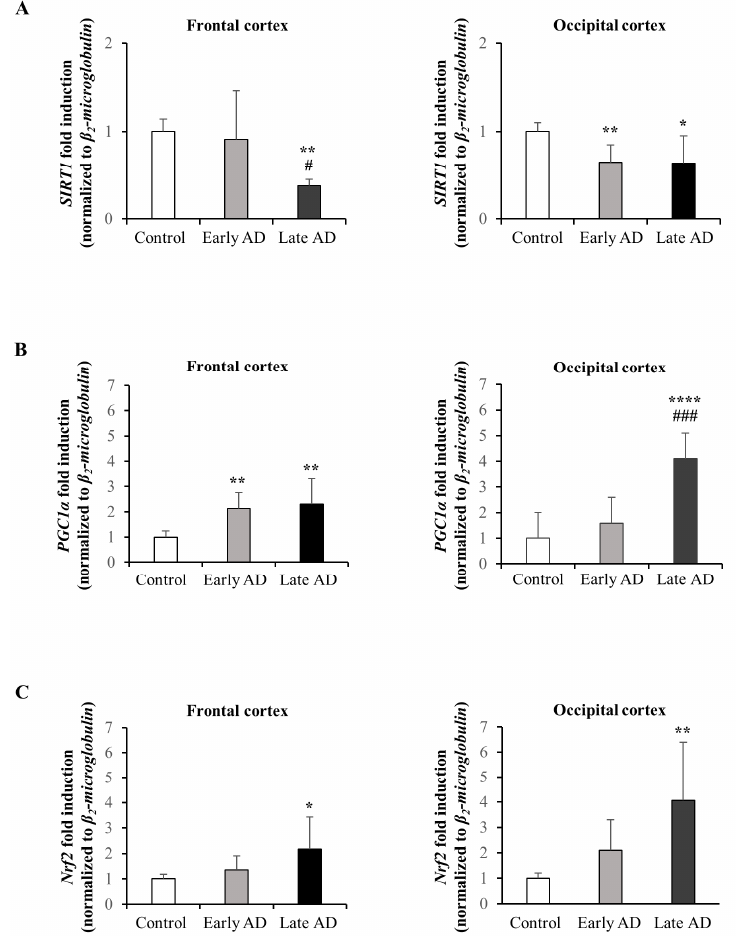
Figure 7. Gene expression of SIRT1 ( A ), PGC1 α ( B ), and Nrf2 ( C ) in brain samples. Gene expression was quantified by real-time RT-PCR in all autopsy specimens from the frontal and occipital cortex of AD patients at different stages of neurofibrillary pathology (Early AD: n = 6; Late AD: n = 8) and healthy subjects (Control: n = 9). Data, normalized to the corresponding β 2 -microglobulin, are expressed as mean values ± SD. * p < 0.05, ** p < 0.01, **** p < 0.0001 vs. control; # p < 0.05, ### p < 0.001 vs. Early AD.